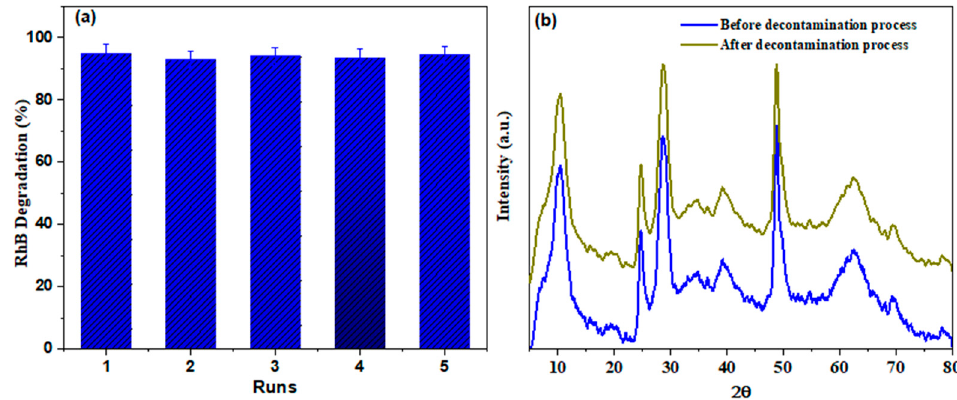
Figure 8. ( a ) Durability of Zn-TNTs in photodegrading RhB up to five runs under visible-light irradiation for 120 min, and ( b ) XRD patterns of Zn-TNTs before and after 5 consecutive runs.